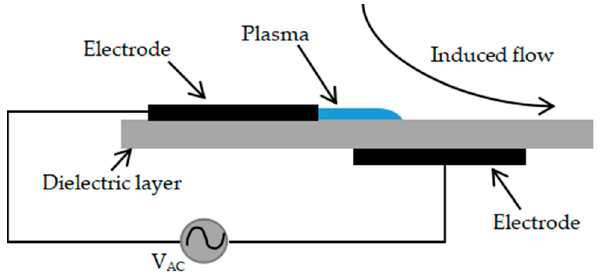
Figure 2. Surface dielectric barrier discharge (SDBD) plasma actuator structure.